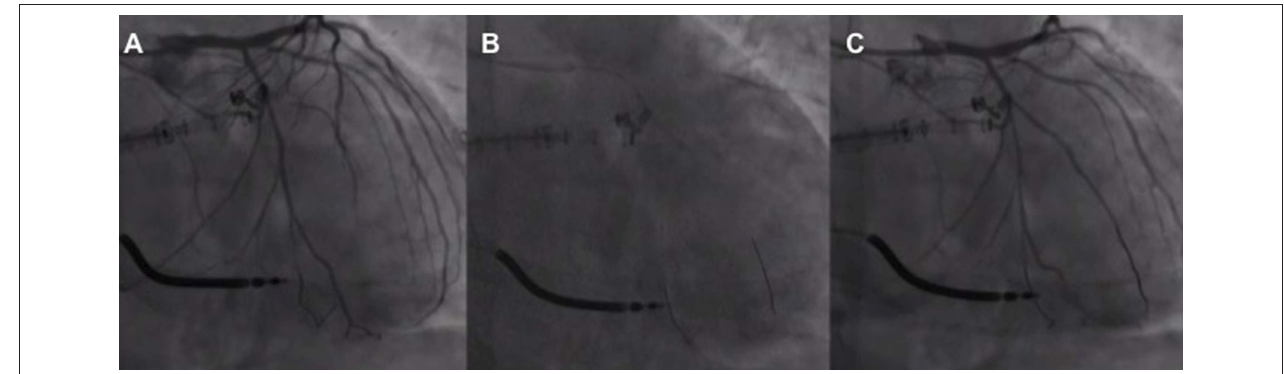
FIGURE 5 | First obtuse marginal narrowing associated with the slow flow (A) following implantation and release of the first Cardioband anchor managed with non-compliant balloon inflation (B) with narrowing resolution and flow restoration (C) .